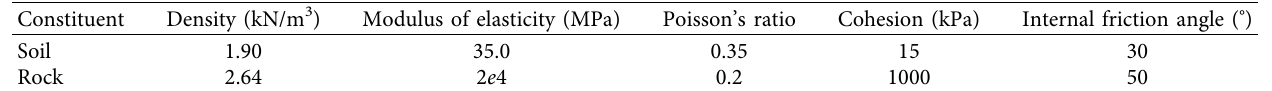
Figure 15: Analytical results of uniform slope (0% rock content). (a) FEM results without top loading. (b) FEM results considering top loading. Table 2: Calculation model parameters of soil-rocks